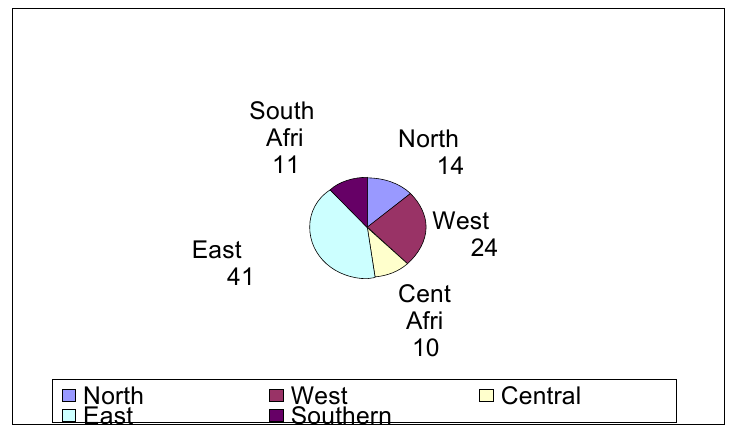
Figure 1: Natural disasters in Africa: 1974 to